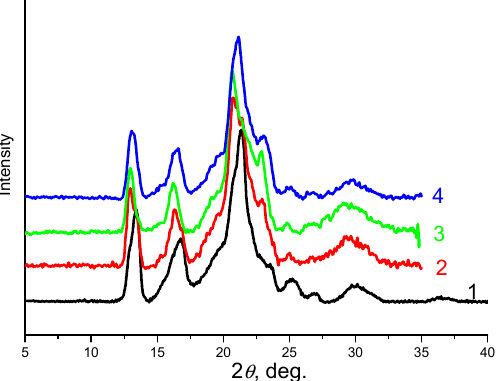
Figure 13. X-ray diffraction patterns of the PHBV/PCL(1:1) mixture (1); PHBV/PCL(1:1)/CNC(PVP)–